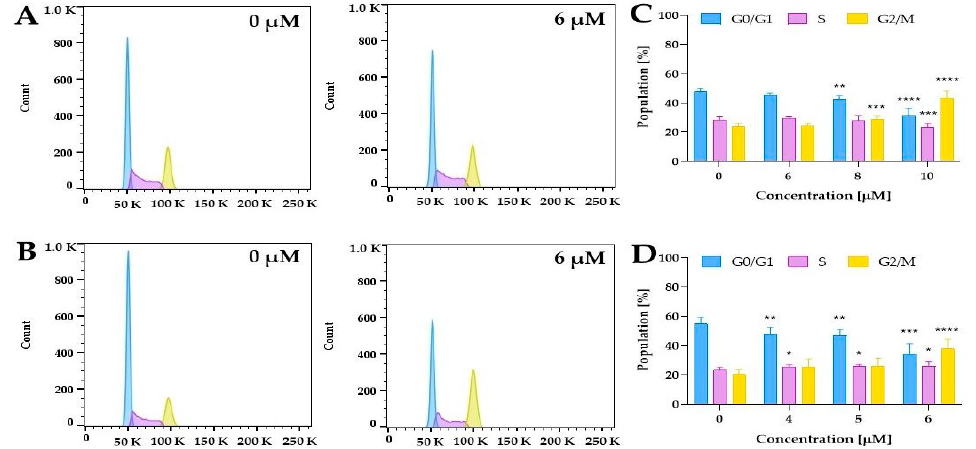
Figure 13. Cell cycle distribution after the treatment of 5637 cells with compound 5 under normoxic and hypoxic conditions. Cells were treated with compound 5 at a concentration of 6 µM, 8 µM, and 10 µM (normoxia), and 4 µM, 5 µM, and 6 µM (hypoxia) for 24 h and stained with propidium iodide. DNA content was analyzed by flow cytometry. Panels ( A ) and ( B ) present representative histograms for normoxia and hypoxia experiments, respectively. Panels ( C ) and ( D ) show the quantification of results for normoxic and hypoxic conditions, respectively. Results are presented as the mean ± standard deviation from three experiments. The asterisk indicates statistical significance * p < 0.05, ** p < 0.01, *** p < 0.001, and **** p < 0.0001 vs. the control group. Statistical significance was measured by one-way ANOVA Dunnett’s multiple comparisons